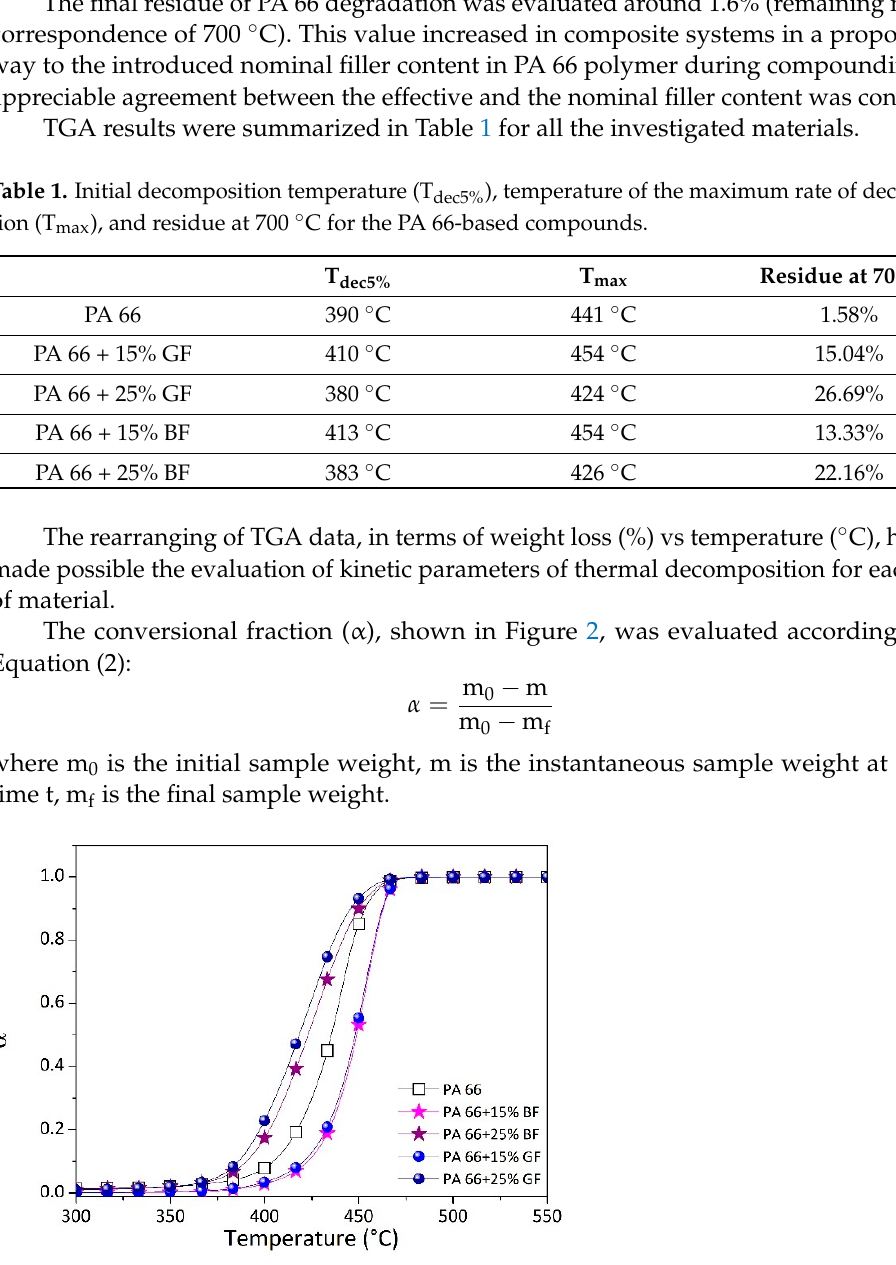
Figure 2. Conversional factor vs temperature for all investigated materials.